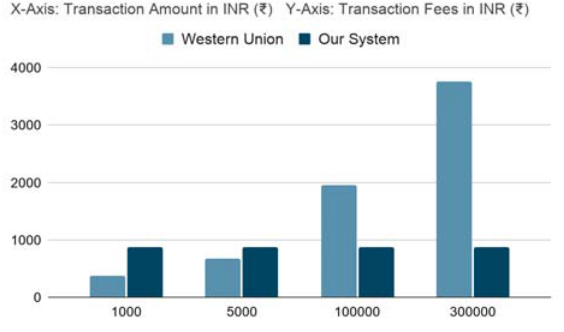
Figure 7. Transferred Amount v/s Transaction